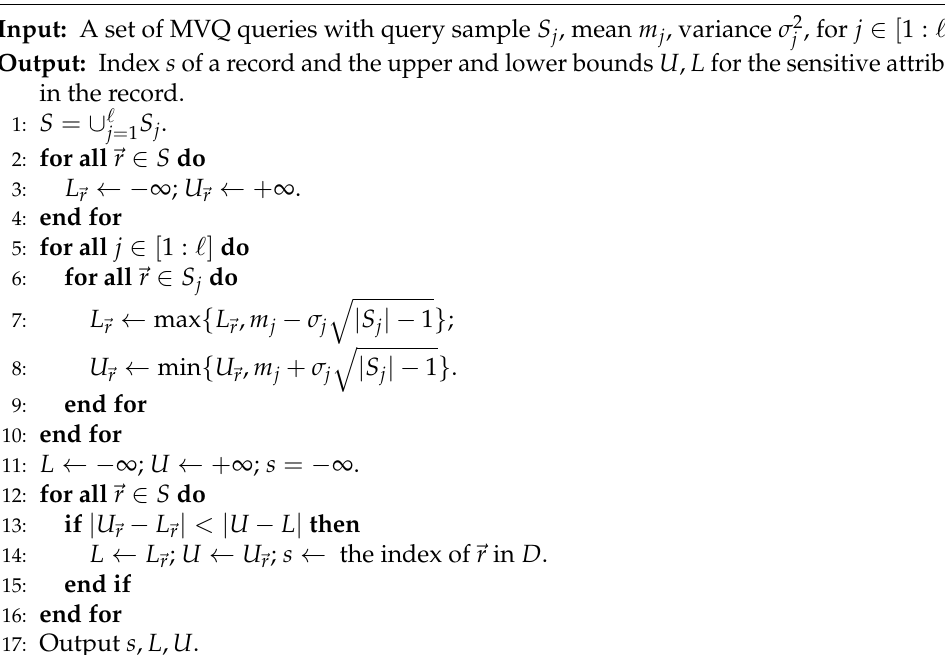
Algorithm 3 Interval Inference